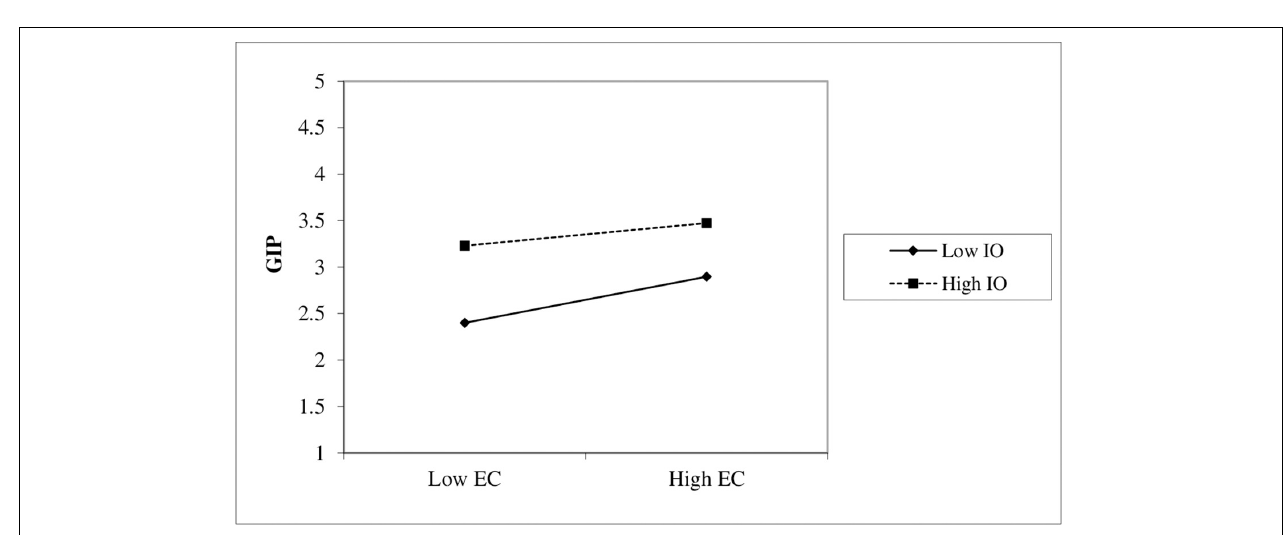
FIGURE 3 | Interaction graph EC × IO and